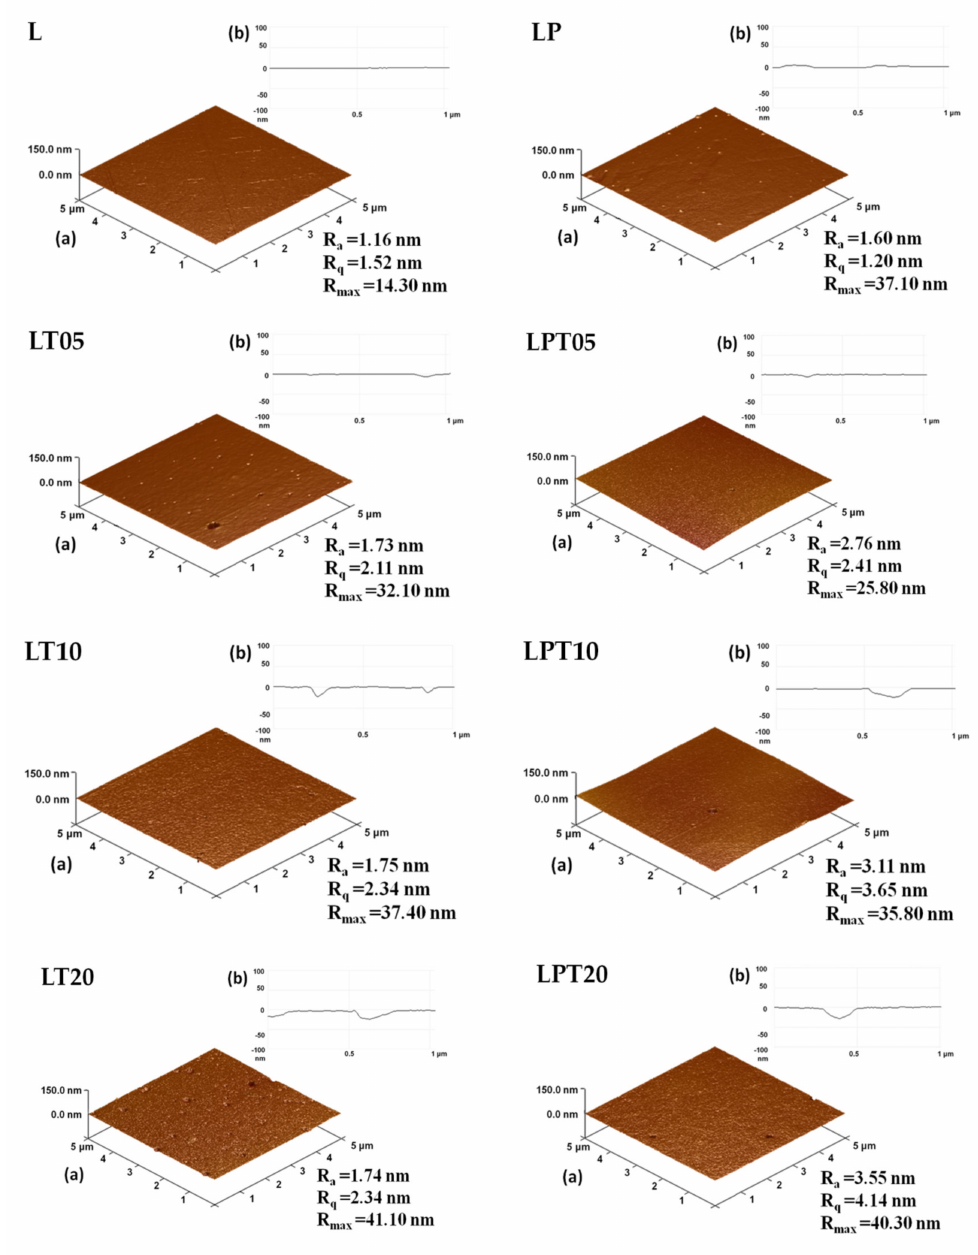
Figure 3. Roughness of PLA-based films (( a ) 3D imaging and ( b )